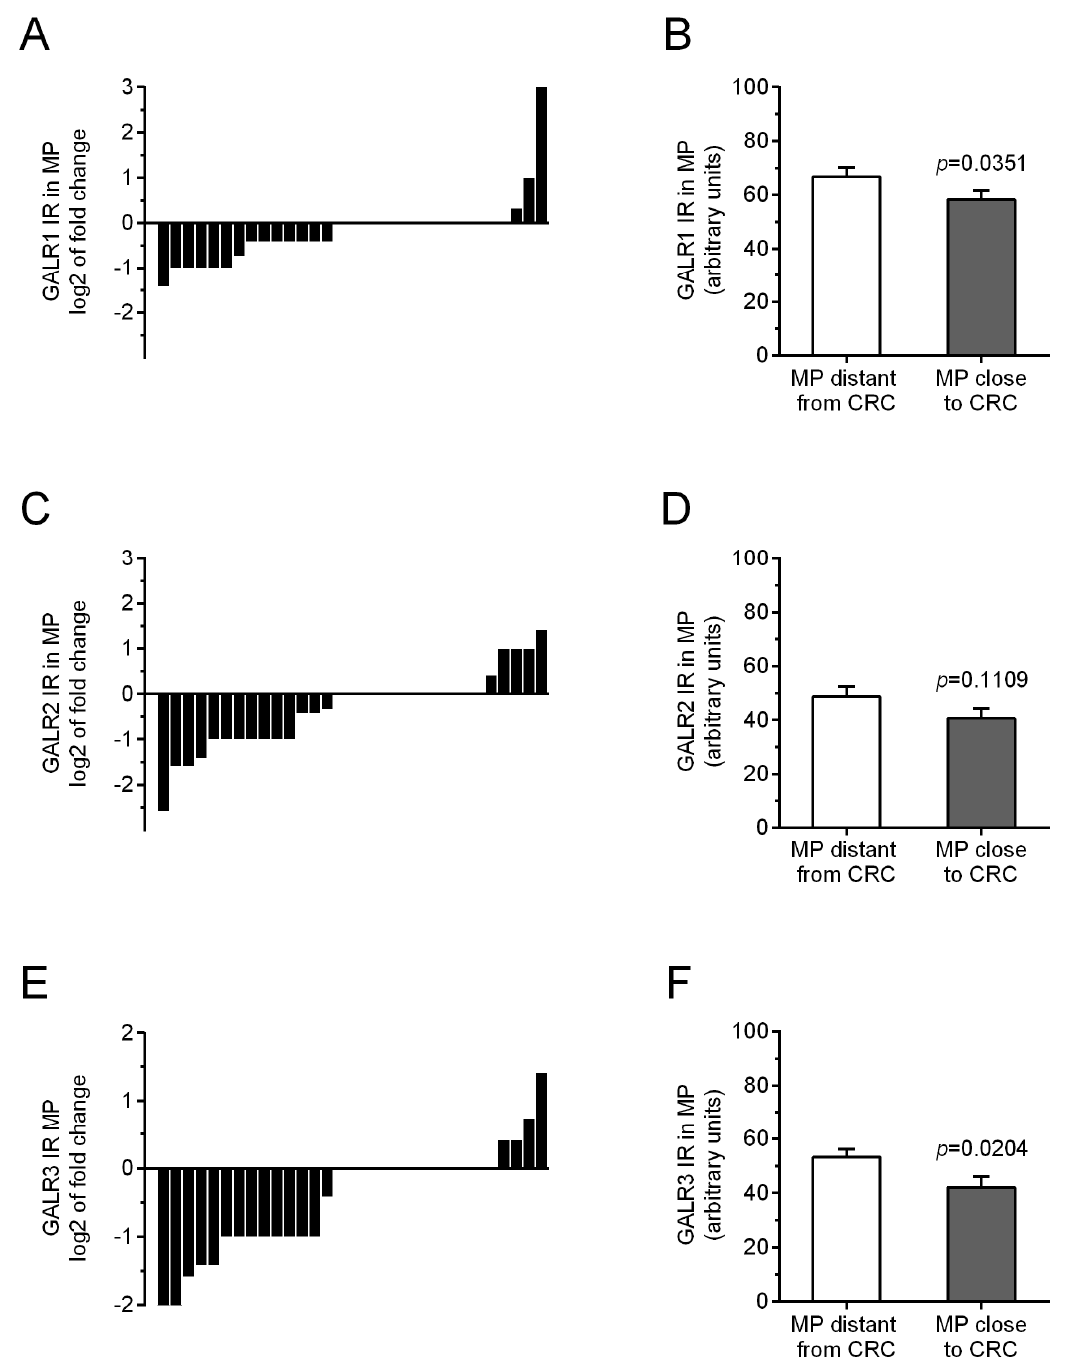
Figure 2. Immunoreactivity (IR) of galanin receptors (GALR1—( A ), GALR2—( C ), and GALR3— ( E )) in myenteric plexuses (MP) distantly and proximity located to cancer invasion in individual colorectal (CRC) patients. The average immunoreactivities of GALRs (GALR1—( B ), GALR2—( D ), and GALR3—( F )) in myenteric plexuses (MP) located distantly from CRCcells were compared with those in plexuses in the vicinity of cancer cells of colorectal (CRC) patients (n = 31). 2.2. Fluorescent Immunolocalization of GALR1, 2 and 3 in Myenteric Plexuses Distantly and Closely Located to CRC Tissue The immunoexpression of GALR1, 2 and 3 was confined to the cell membrane and cytoplasm of myenteric plexus cells and smooth muscle cells (Figure